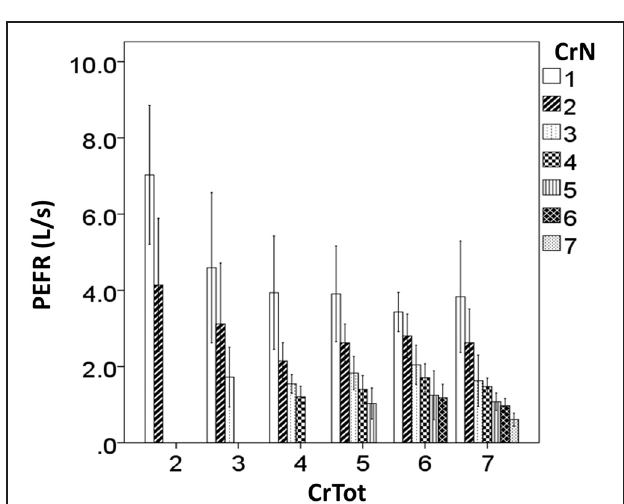
FIGURE 5 | Cough inspired volume according to the total number of cough re-accelerations within the epoch